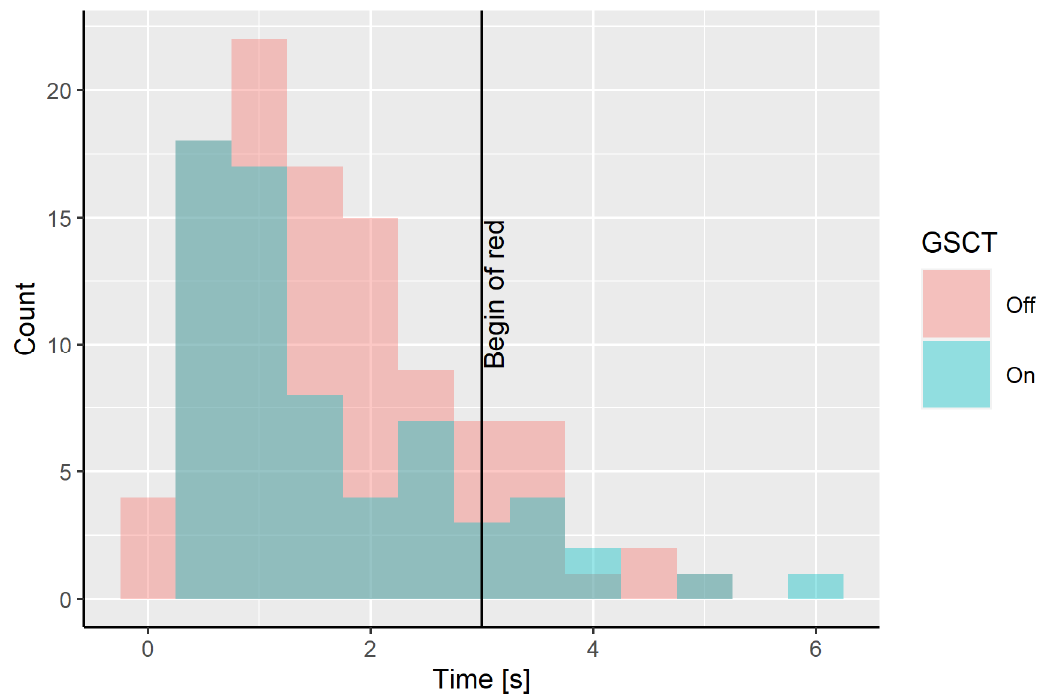
Figure 9. Boxplots of the time of entry after the end of the green signal. Additionally, for the entire population of registered entries after the end of the red signal, a histogram of the entry time measured from the end of the green signal was developed, as shown in Figure 10. Both graphs show the moment of the signal change to red. The red color refers to the situation with the GSCT turned off, and blue color with the GSCT turned on.